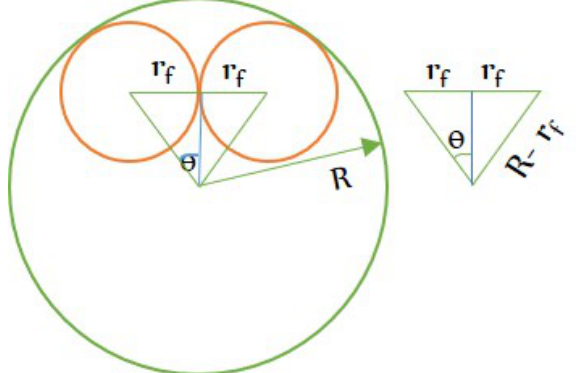
Figure 4. Arrangement of circles in a large